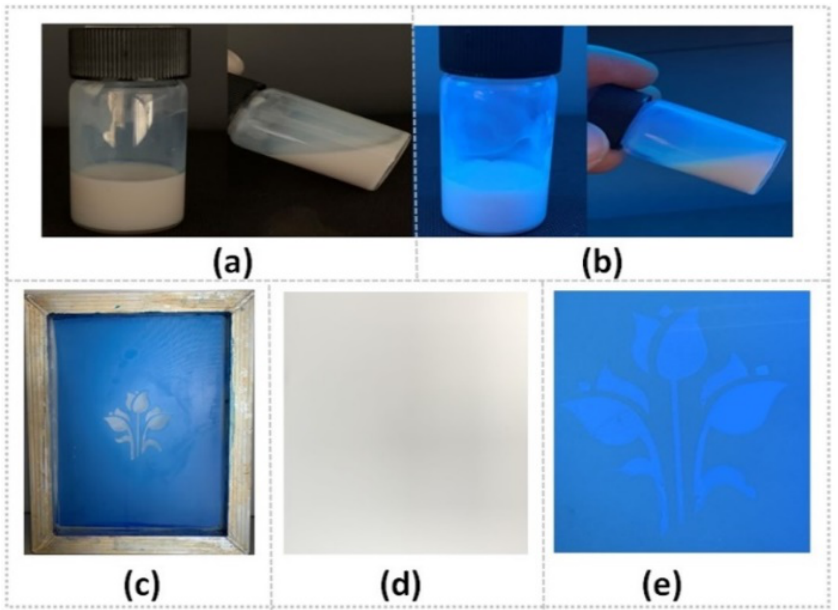
Figure 7. ( a )The PTSA-SiNP ink under sunlight and ( b ) 365 nm UV light; ( c ) its screen-printing process of the printing plate and ( d ) printing pattern under sunlight and ( e ) 365 nm UV